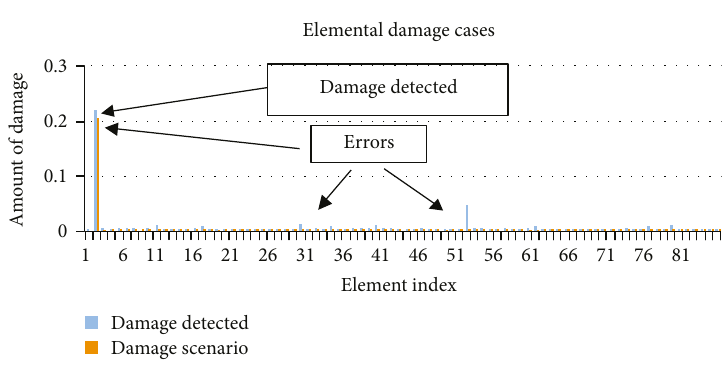
Figure 12: Damage locations in damage scenario 3.